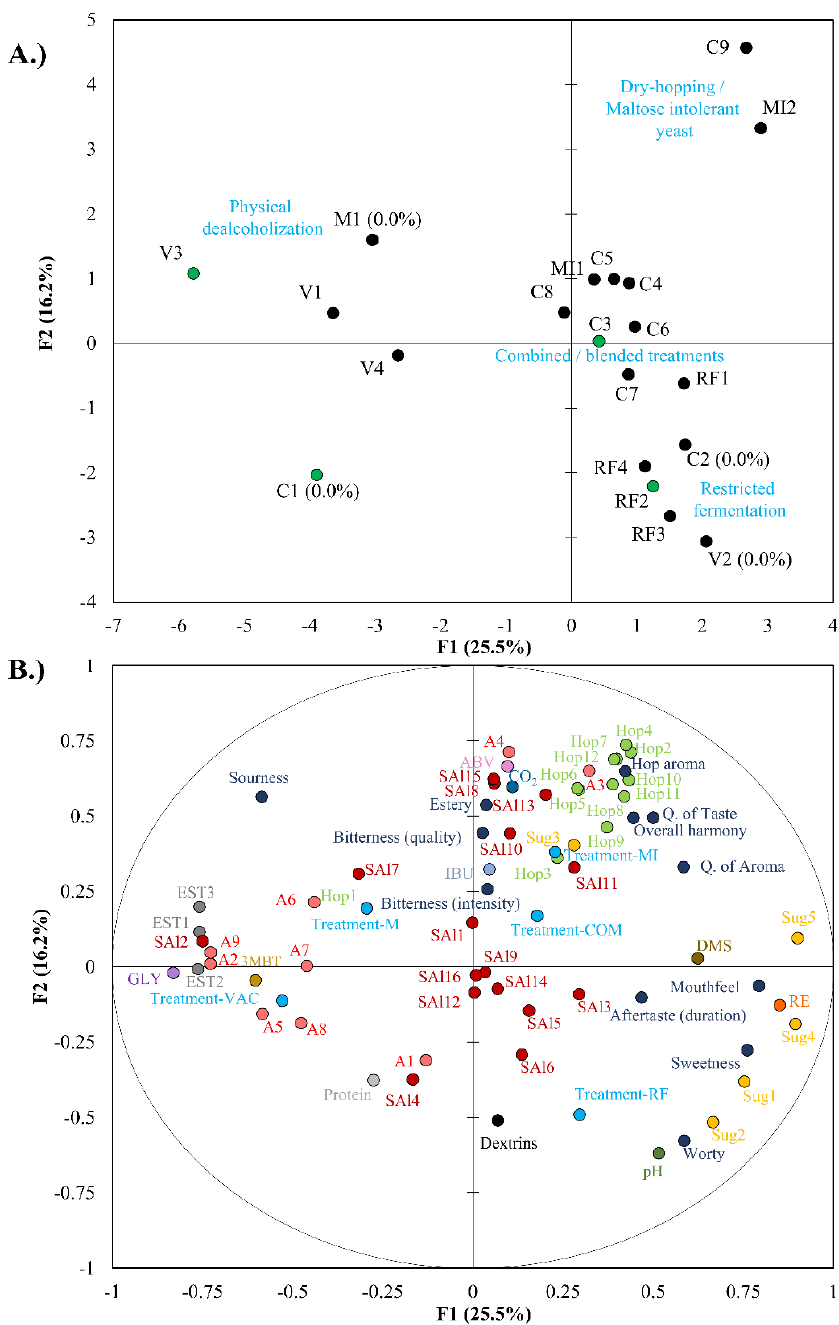
Figure 2. To observe the differences between the different pilsner style NABs, multiple factor analysis (MFA) was performed. ( A ) The observation factor chart showing the NABs in the MFA space. The sample labels are reported in Table 1 and the different treatments are abbreviated as follows: use of Maltose-intolerant yeast (MI), Restricted fermentation (RF), Membrane dealcoholization (M), Vacuum dealcoholization (V), Combined treatments (C). ( B ) The correlation circle map of the MFA with the qualitative (i.e., treatments (turquoise)) and quantitative (i.e., sensory (dark blue), esters (dark gray), hop volatiles (light green), staling aldehydes (dark red), aldehydes/alcohols/esters (light red), sugars (light orange), glycerol (purple), ABV (pink), IBU (light gray blue), DMS (dark brown), 3MBT (light brown), CO 2 (dark gray blue), pH (dark green), protein (light gray), and dextrins (black)) factors. During the initial computations, only the quantitative factors were considered. The codes for the factors are defined in Tables